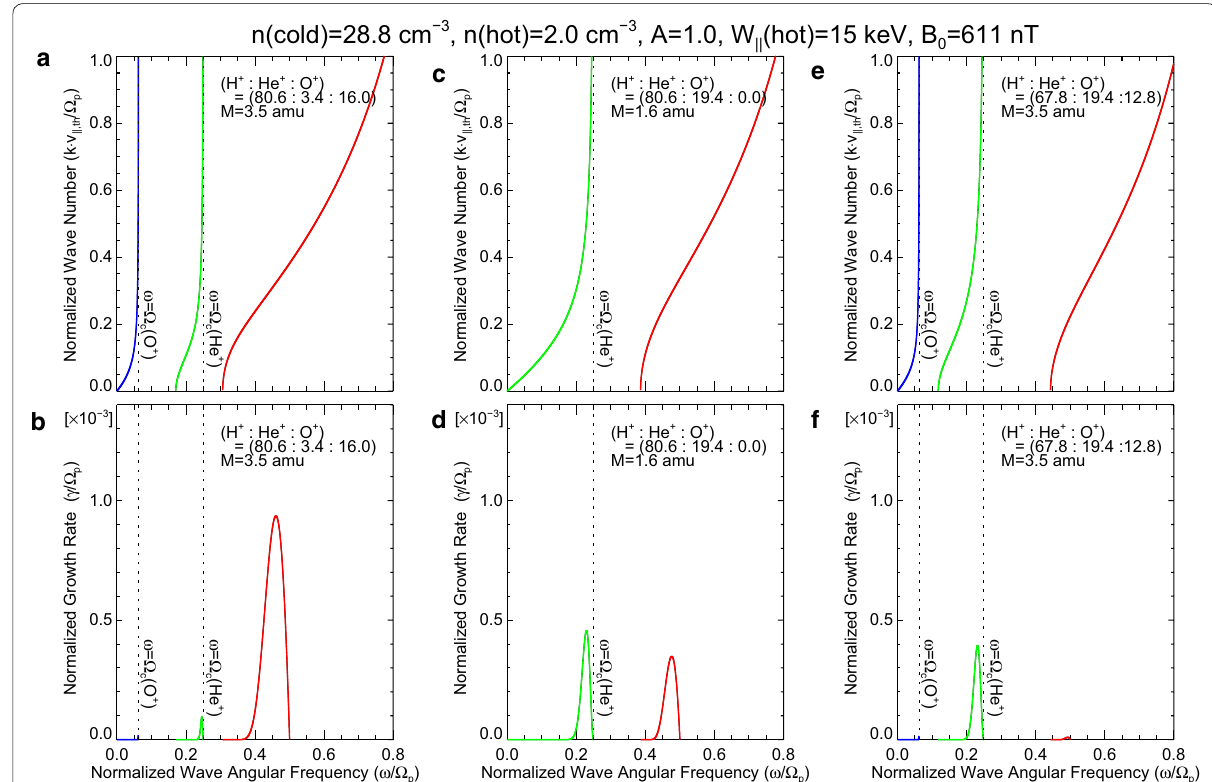
Fig. 7 Solution of the linearized dispersion relation for electromagnetic ion cyclotron (EMIC) waves. a Wave number and b growth rate as a function of wave angular frequency for the oxygen torus case, that is, ion composition of (H + :He + :O + ) present the branch of the H + , He + , and O + band EMIC waves, respectively. Parameters used in the calculation are displayed in the top of panels. c , d Same as in a , b except for the no O + ion case, that is, the ion composition of (H + :He + :O + ) identical to the oxygen torus case (3.5 amu) with less O + ions, that is, the ion composition of (H + :He + :O + )